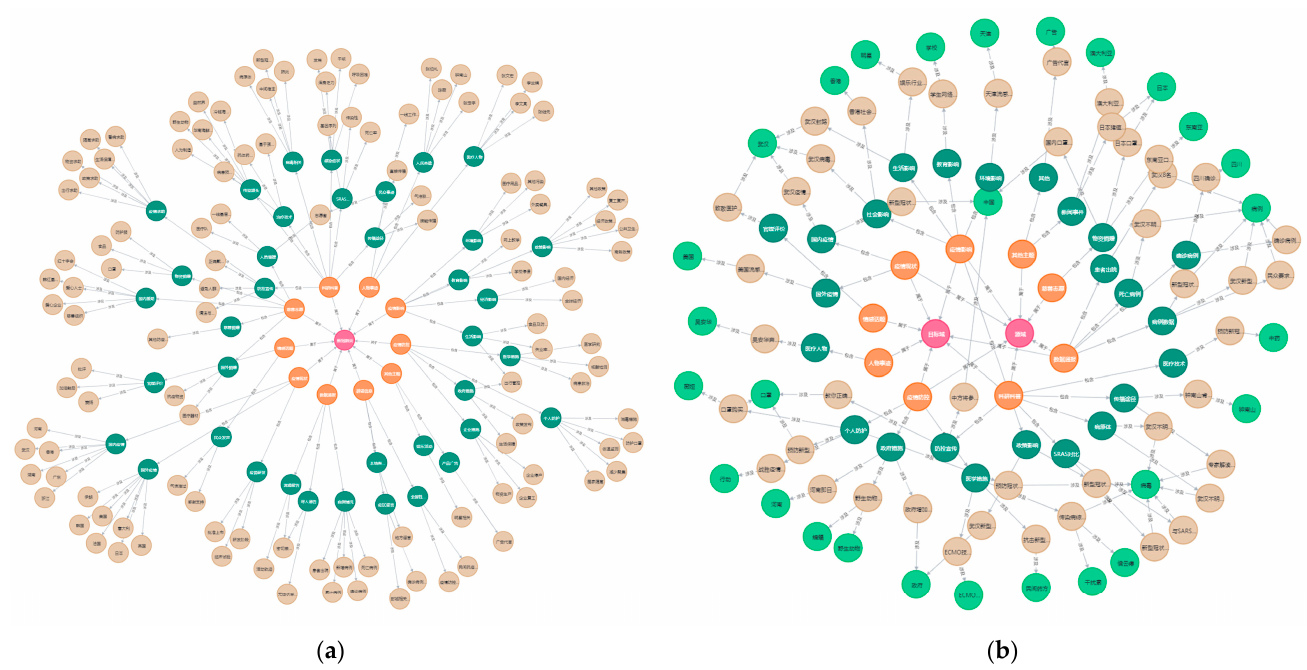
Figure 11. This is the topic knowledge graph constructed by using Neo4j graph database: ( a ) is the COVID-19 Topic Knowledge Graph; ( b ) is the topic knowledge graphs of source domain T2 and target domain T3.